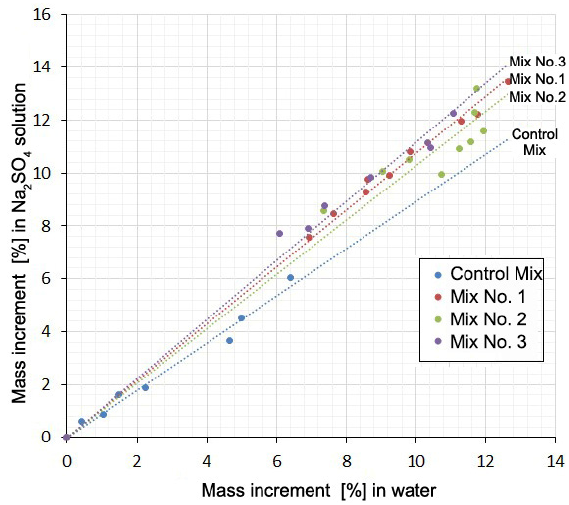
Figure 4. Deformation of compositions depending on the amount of absorbed substance: ( a ) Control Mix; ( b ) mix with Zolest-bet additive (Mix No. 1); ( c ) mix with silica fume additive (Mix No. 2); ( d ) sulfate-resistant Portland cement (Mix No. 3); 1—at water hardening; 2—at 5% Na 2 SO 4 solution hardening.